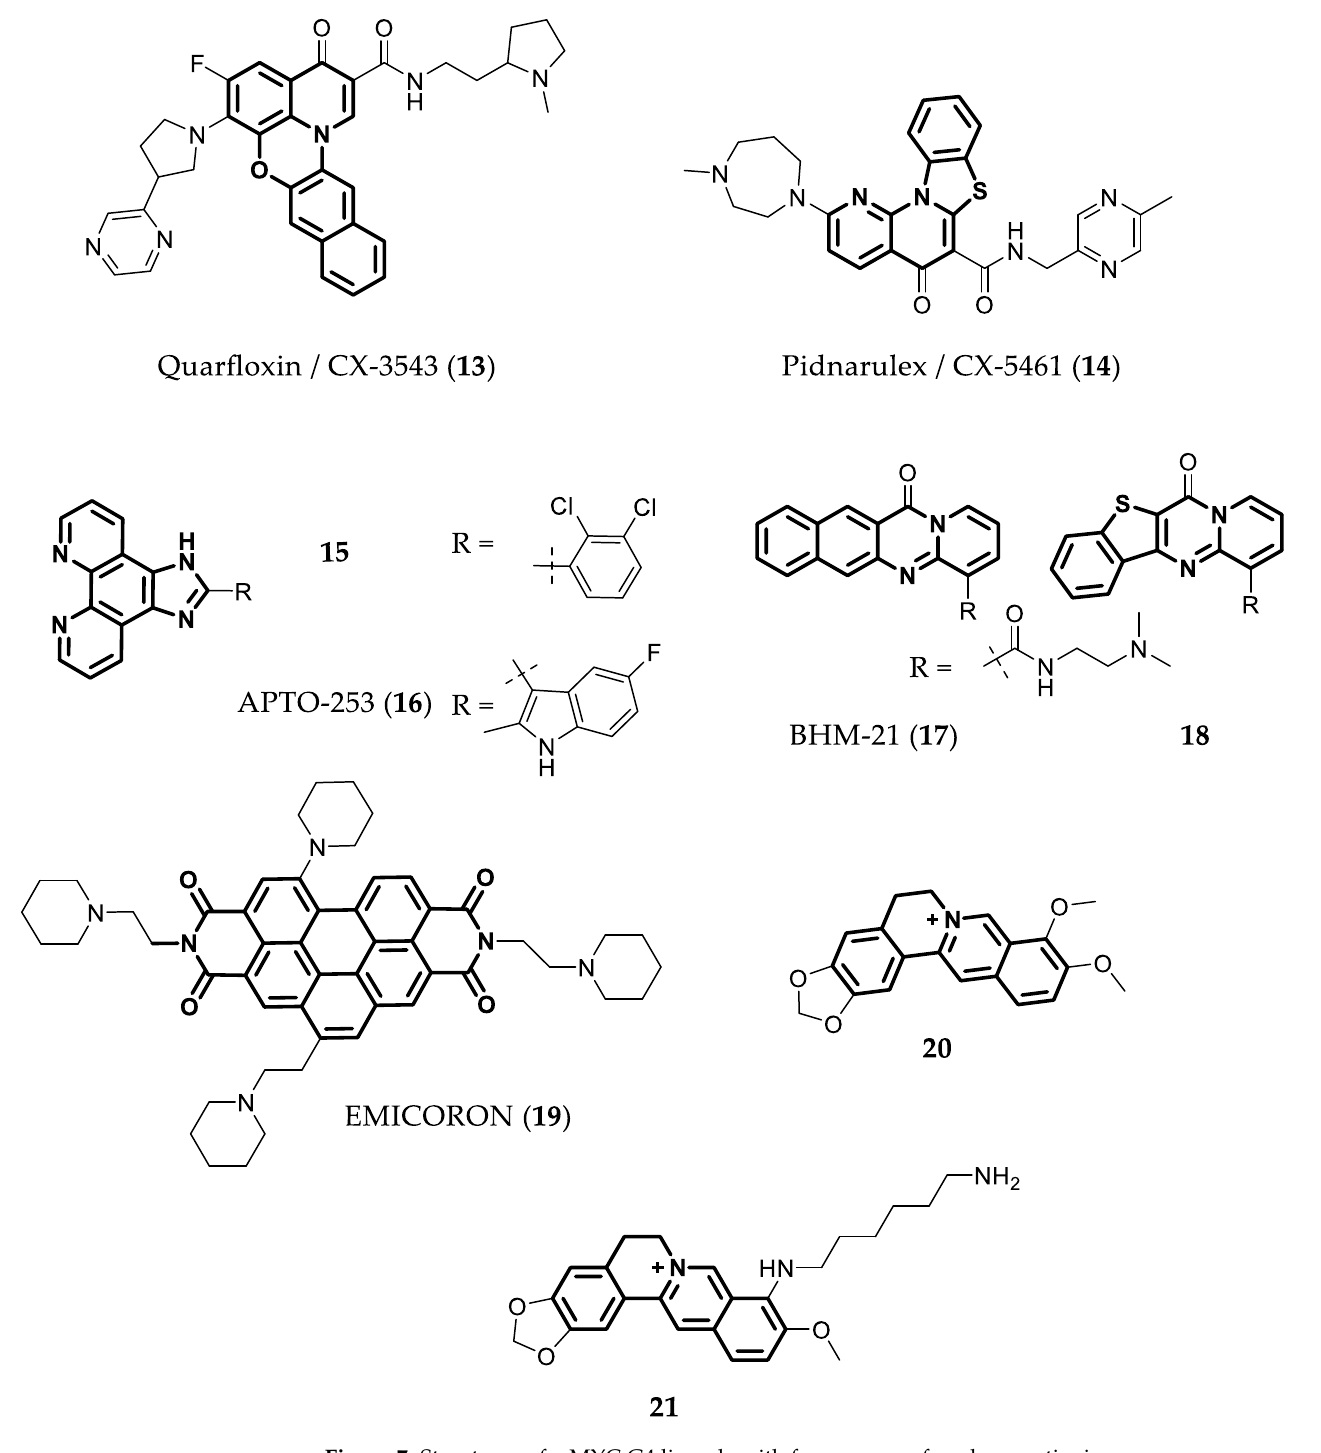
Figure 7. Structures of c-MYC G4 ligands with four or more fused aromatic rings.